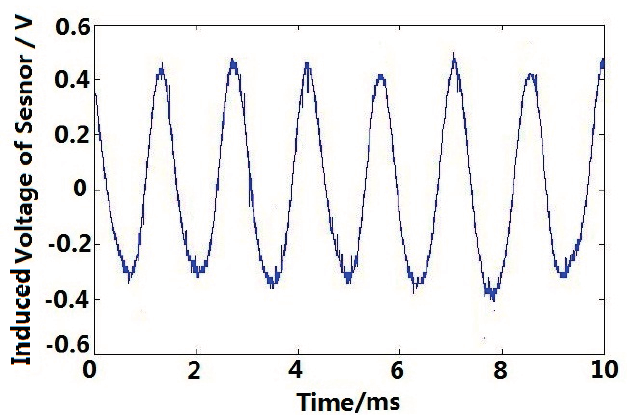
Figure 21. Angular acceleration in continuous operation